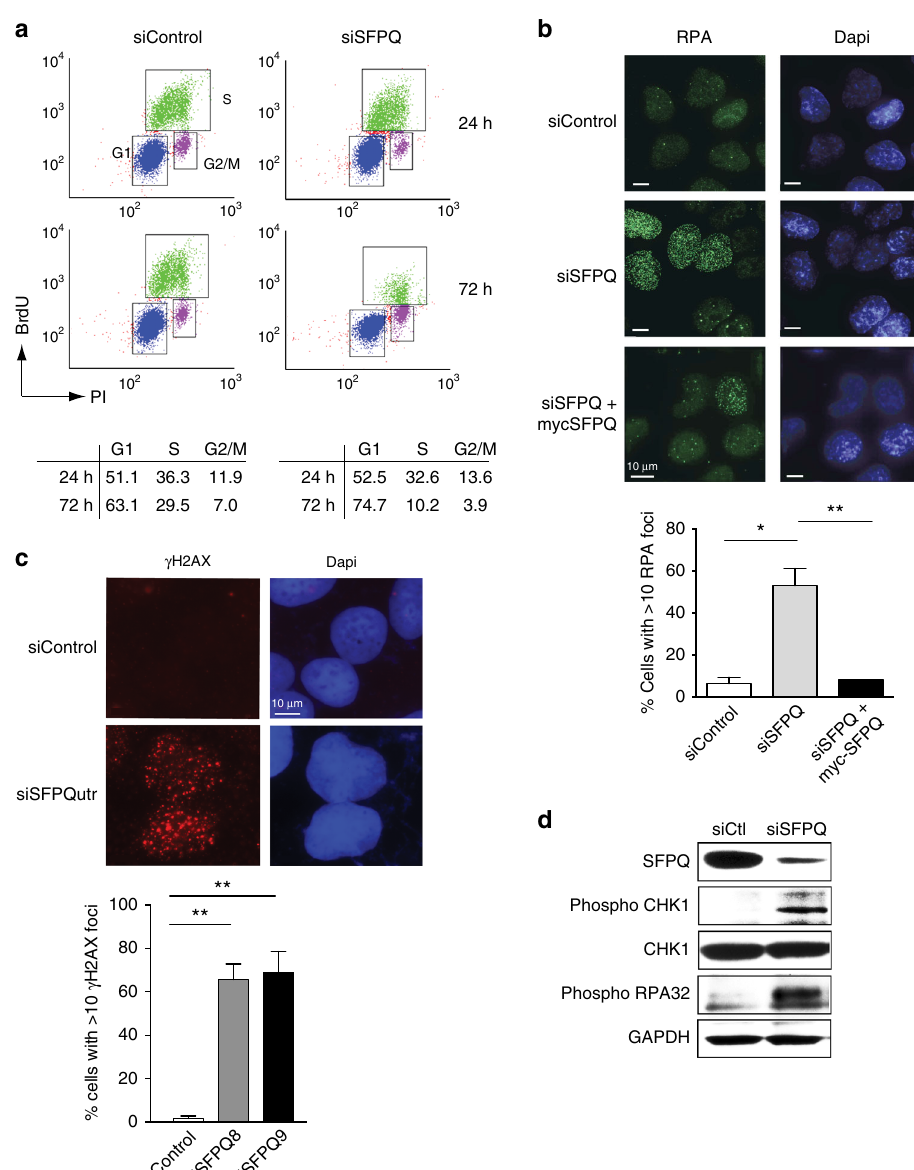
Fig. 2 Defects in SFPQ cause replication stress. a FACS analysis showing that knockdown of SFPQ (siSFPQ9) leads to a reduction in the s-phase cells. Quanti fi cation of FACS data was averaged from three independent experiments. b Microscope images showing that knockdown of SFPQ with siSFPQ8 in U2OS cells leads to increased RPA foci. Expression of exogenous myc-SFPQ (indicated) resulted in partial suppression of RPA foci in SFPQ-depleted cells. Quanti fi cation is shown below and indicate mean percentage of cells with >10 RPA foci ± s.d. More than 100 cells were counted from each of three independent experiments. Statistical signi fi cance was determined using Student ’ s t -test (*<0.05 and **<0.01). c Images showing increased γ H2AX foci in U2OS cells knocked down with siSFPQutr compared with control cells. Graph shows mean percentage of cells with >5 γ H2AX foci ± s.d. Data are plotted from three independent experiments. Statistical signi fi cance was determined using Student ’ s t -test (** p < 0.01). d Western blot showing that knockdown of SFPQ with siSFPQ8 leads to the phosphorylation of CHK1 on serine 345 and phosphorylation of RPA32 on